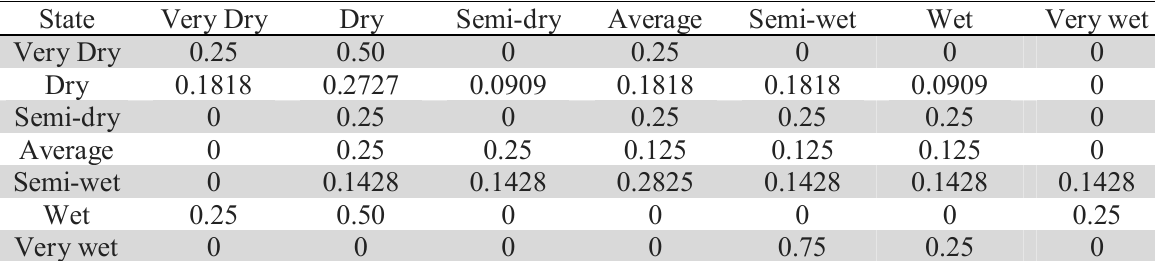
Transfer matrix